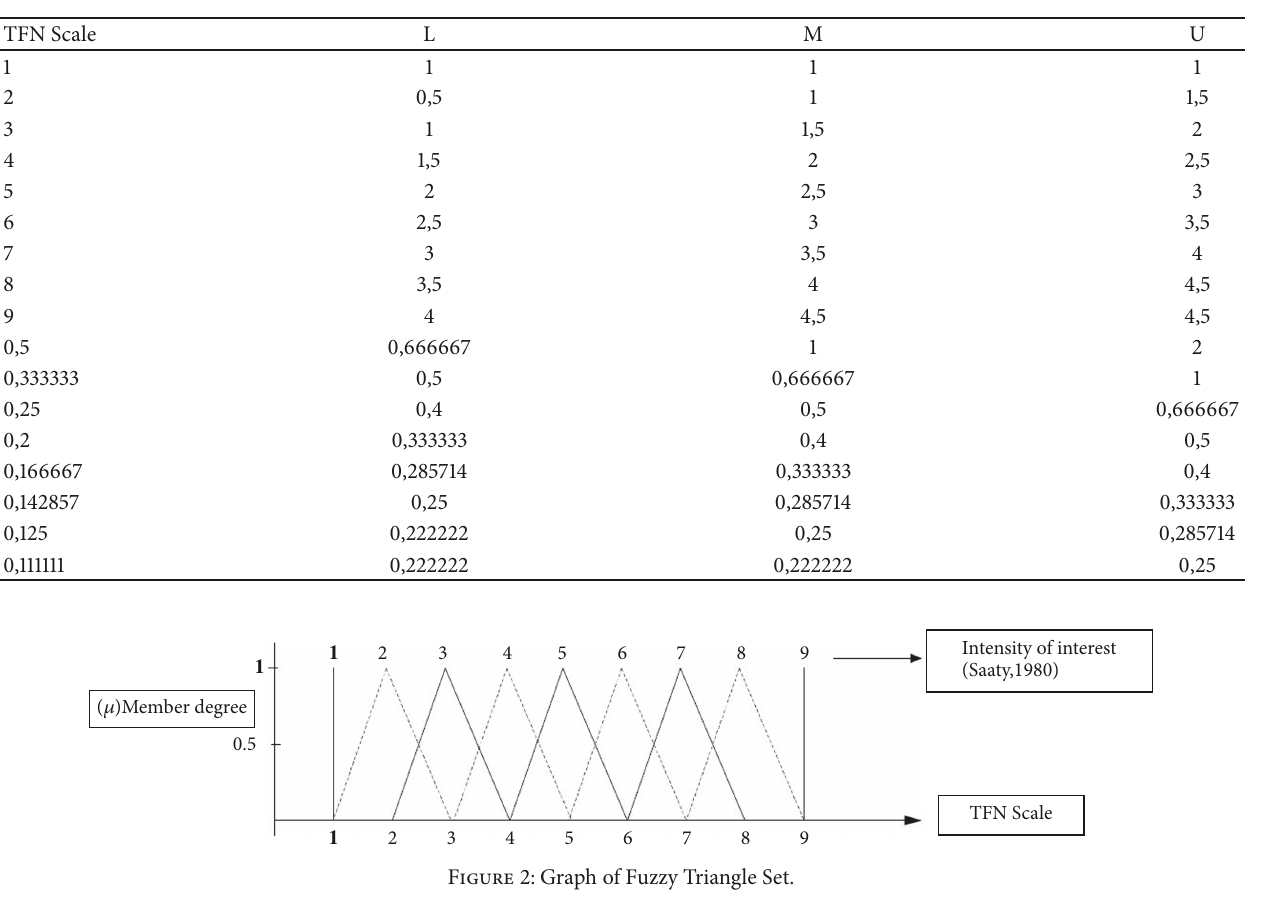
Table 5: TFN scale.